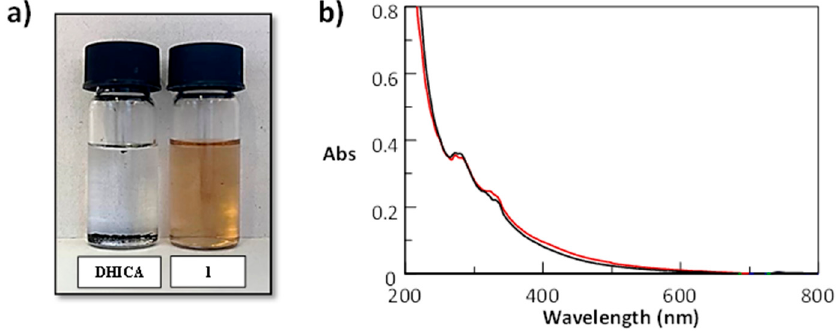
Figure 4. ( a ) Ethanolic solution (3 mg/mL) of the pigment from DHICA carboxybutanamide 1 (right) in comparison with DHICA melanin (left); ( b ) UV–Vis spectrum prior and after filtration of the ethanolic solution of the pigment from 1 (1 mg/mL).